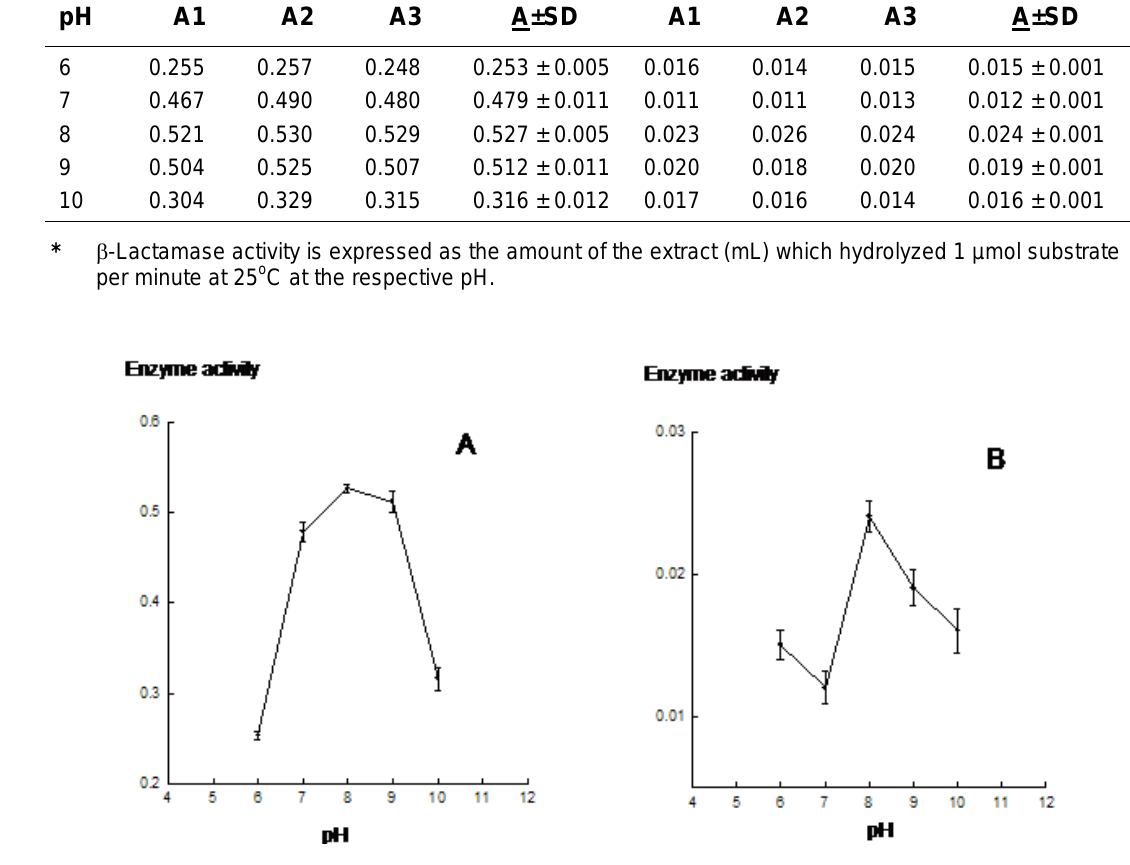
FIGURE 1. Spectrophotometric evaluation of the extracts β -lactamase activity (not induced) against ampicillin (A) and cephalexin (B) at 25 o